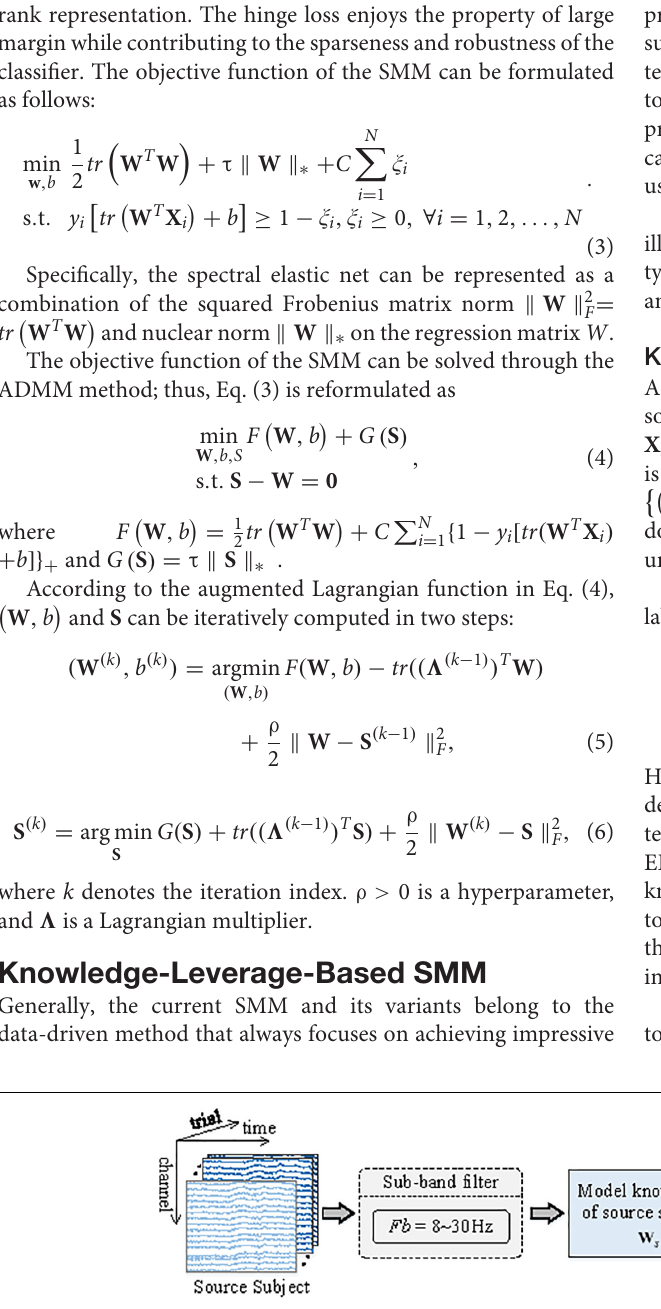
Frontiers in Neuroscience |